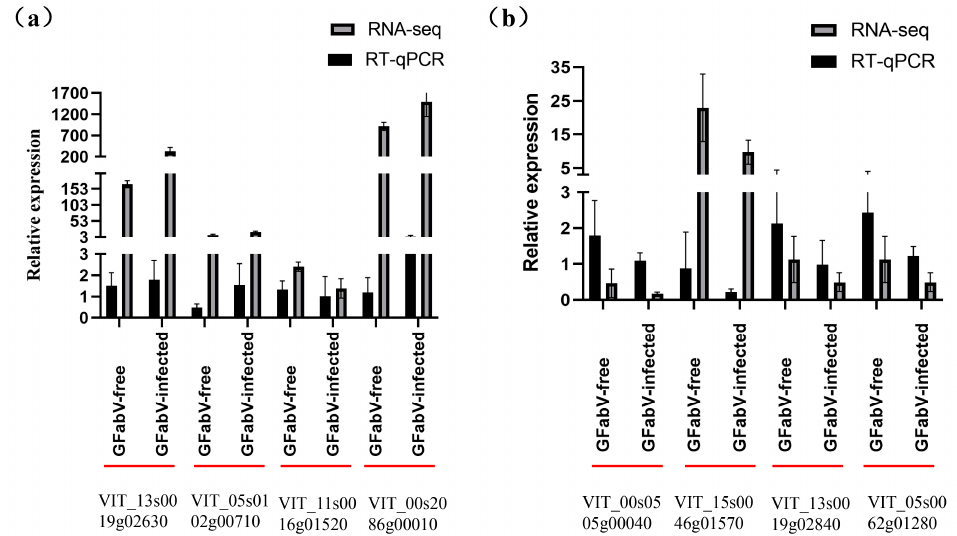
Figure 12. Validation of the expression of genes in ‘Summer Black’ ( a ) berries and ( b ) leaves by RT − qPCR. Error bars represent the standard deviation of three independent biological repeats. Statistically significant results are indicated as P <0.05.